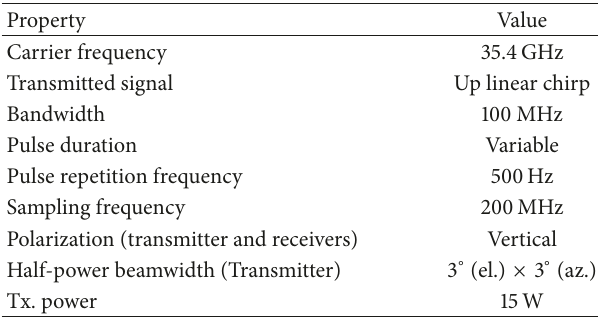
Table 1: Main characteristics of